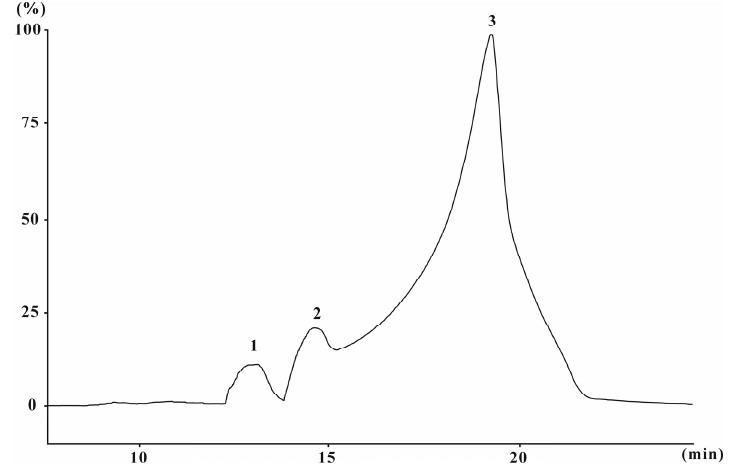
Figure 1. High-performance size-exclusion chromatography (HPSEC) chromatogram of CPOP (crude Portulaca oleracea L. polysaccharide). 1: 9.3 × 10 4 Da, 2: 11.9 × 10 3 Da, 3: 7.3 × 10 3 Da.